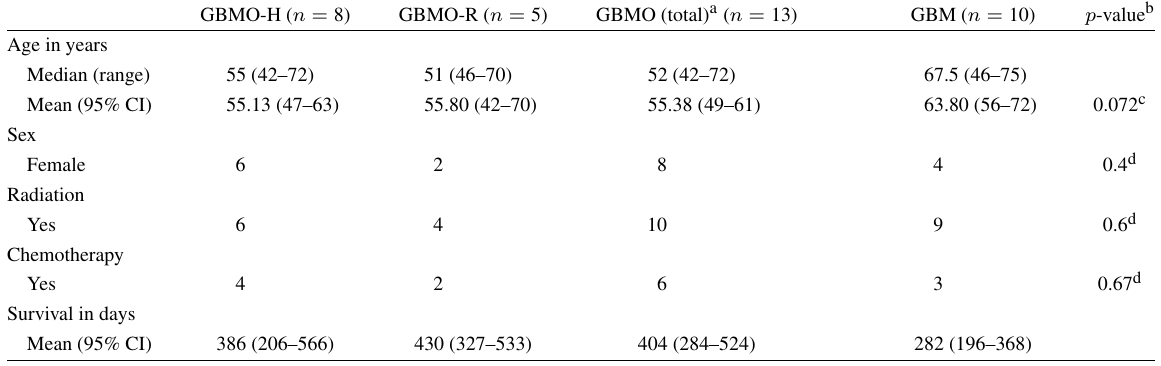
Clinical characteristics of patients with GBMO and